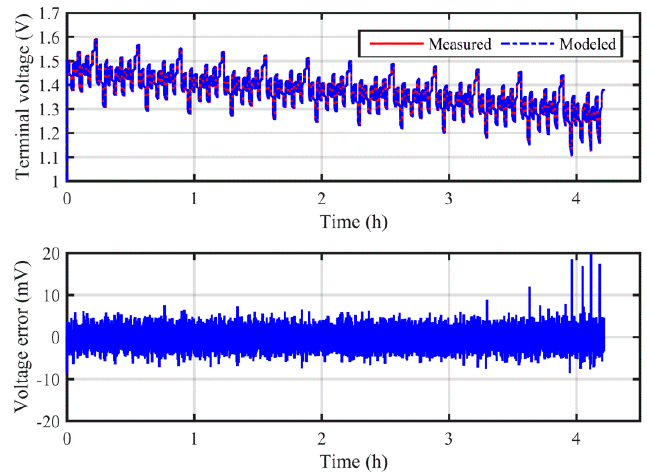
Figure 4. Results of the terminal voltage prediction with the online adapted model.